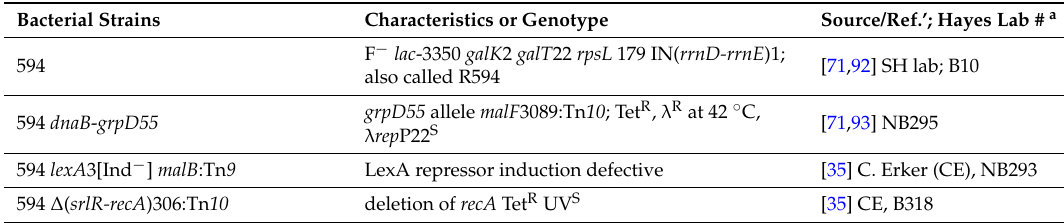
Table 8. Bacteria and plasmids